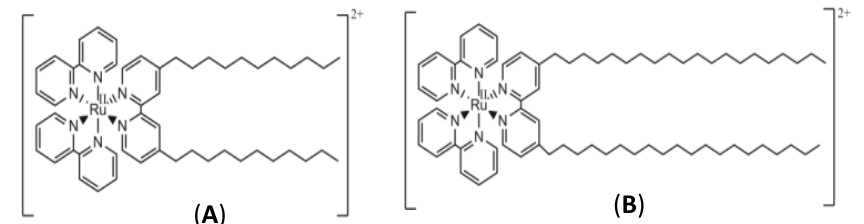
Figure 2. Structures of RuC11C11 ( A ) and RuC19C19 ( B ).